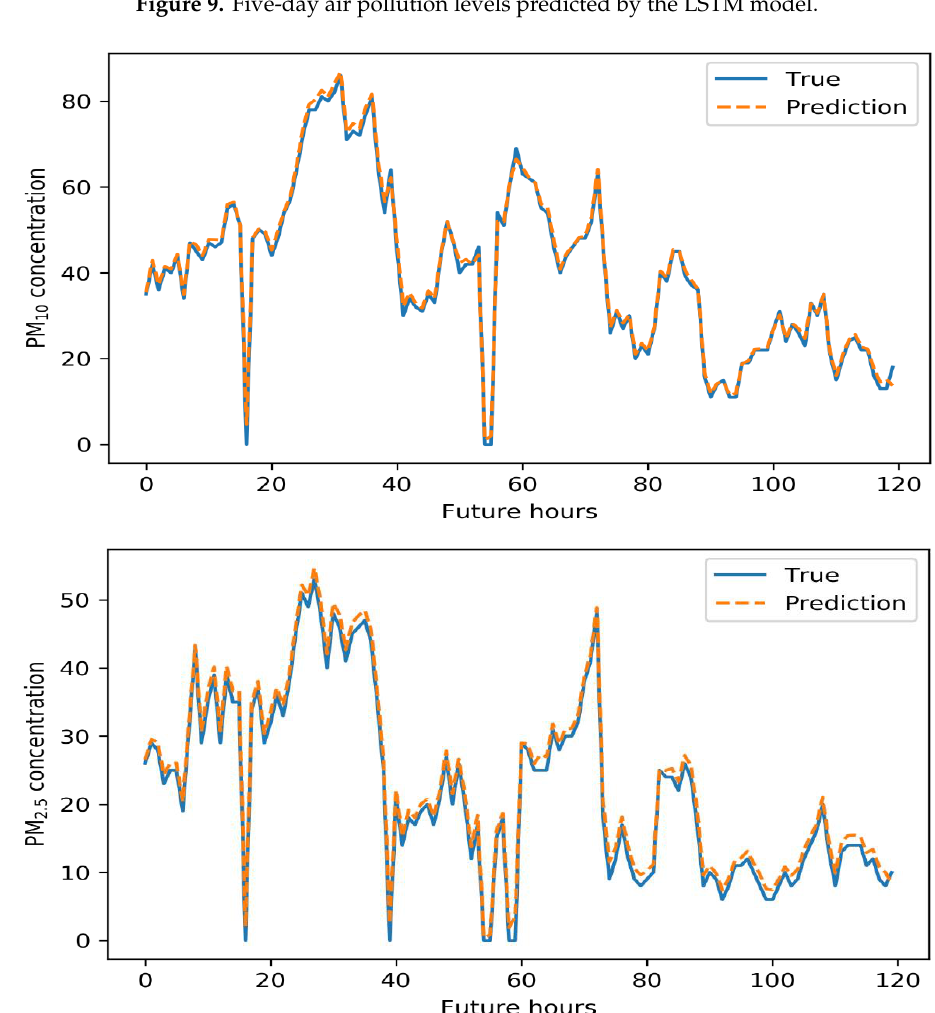
Figure 10. Five-day air pollution levels predicted by the CNN–GRU model.